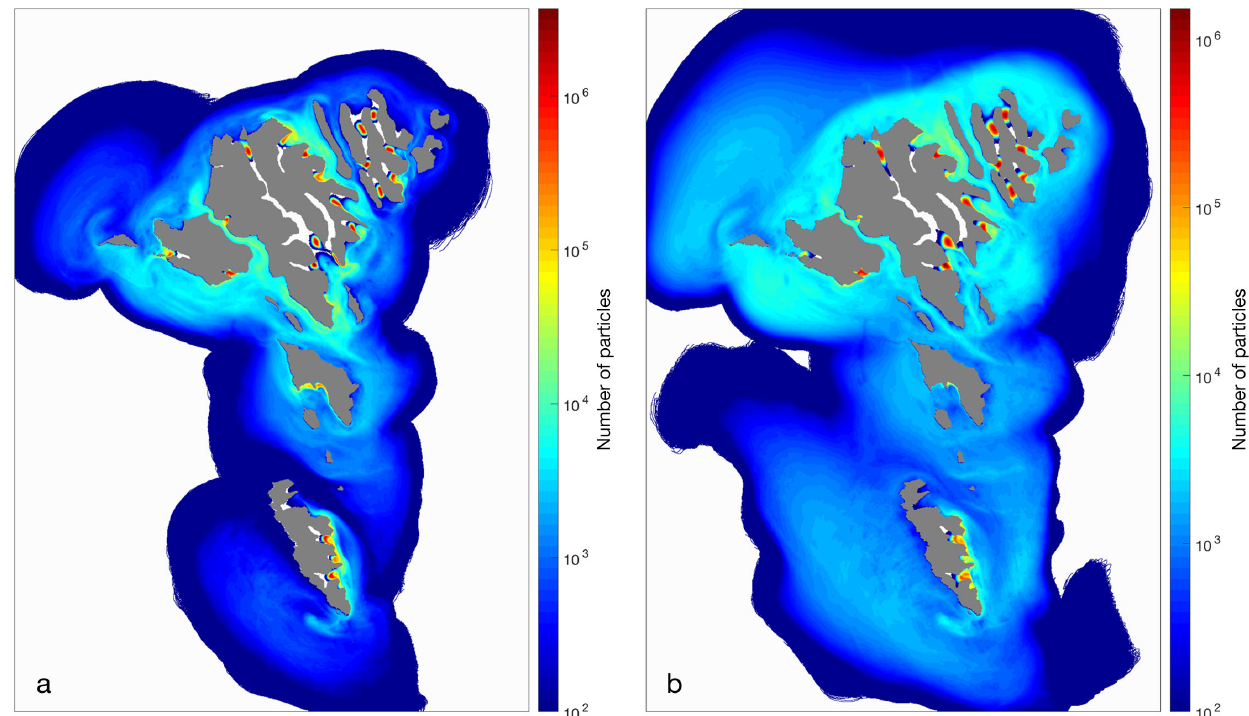
Fig. 6. Relative density distribution attained by particles released from all 24 farm sites, by recording the number of particles in each 100 × 100 m grid cell every time step, including mortality, over the whole 2000 h simulation. (a) Nauplii and (b) copepodid particles. The color bar indicates number of particles on a logarithmic scale; white: no particles registered